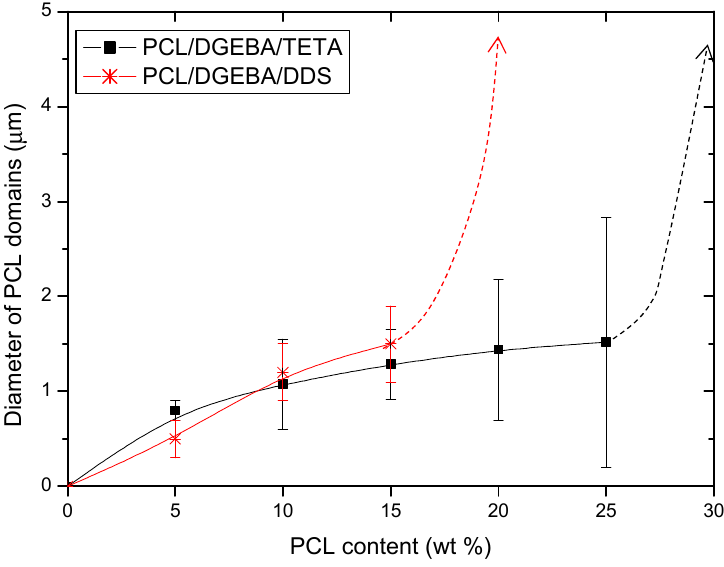
Figure 2. Average diameter of separated thermoplastic phase at PCL content lower than critical composition.